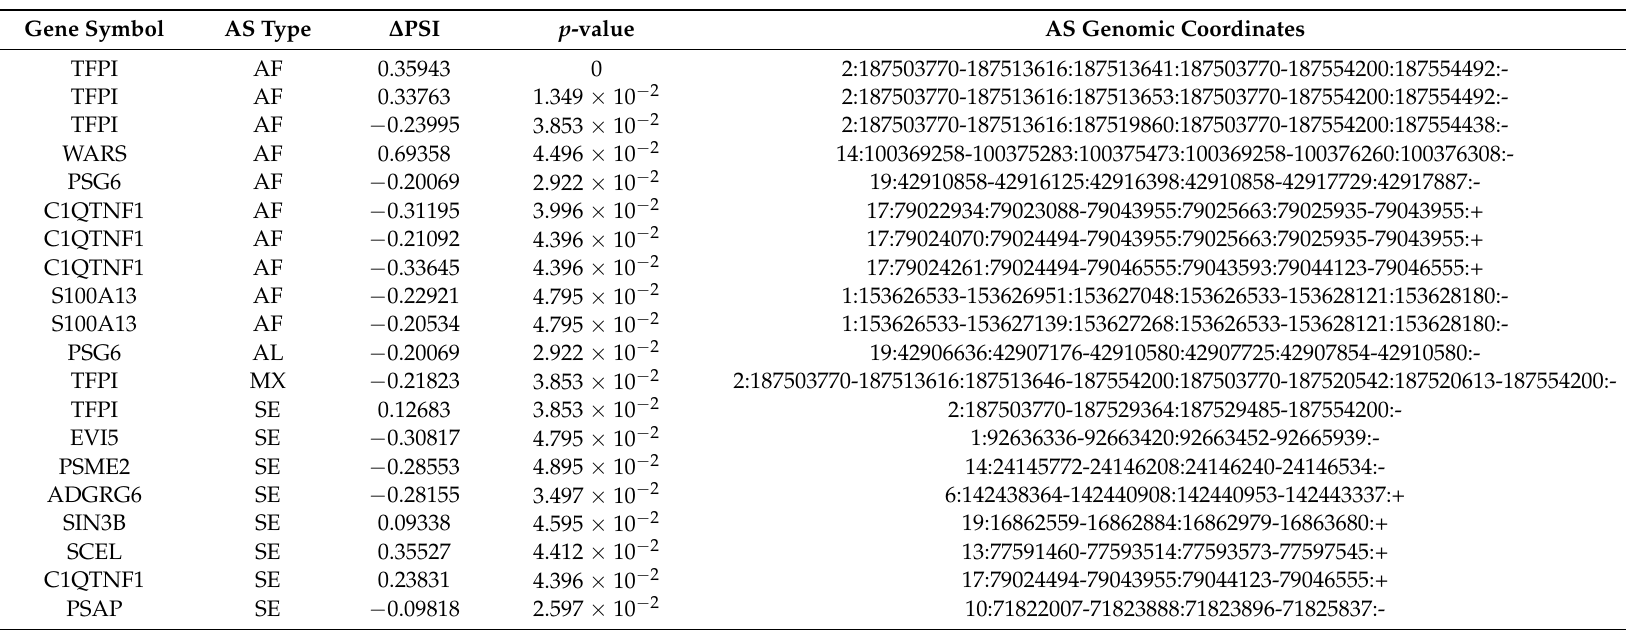
Table 4. Statistically significant AS events identified by Suppa ( p -value < 0.05) and intersected with rMATs (adjusted p -value <